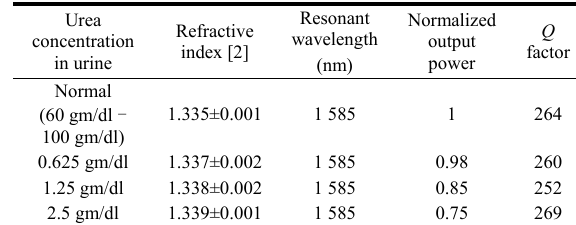
Table 6 Urea concentration in urine and its refractive index, resonant wavelength, normalized output power, and Q factor of the proposed sensor.